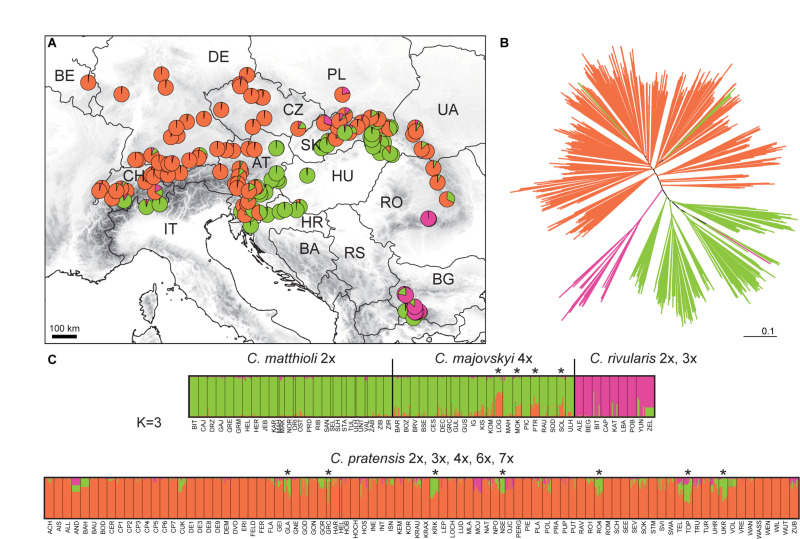
Genetic structure of all species studied, Cardamine matthioli, C. majovskyi, C. rivularis, and C. pratensis, as inferred from microsatellite data analyses of the Complete Matrix. (A) Distribution of the sample sites. Different colors show the population assignment to three genetic clusters as inferred from the STRUCTURE analyses. (B) Neighbor-joining tree diagram, calculated using Lynch distances. (C) Bayesian model-based clustering (STRUCTURE) at K = 3. The coloring of vertical bars indicates each individual’s proportional cluster assignment: green: C. matthioli – C. majovskyi; purple: C. rivularis; orange: C. pratensis. Putative hybrid populations between C. majovskyi and C. pratensis are marked by asterisks. For locality codes see Supplementary Data 1.